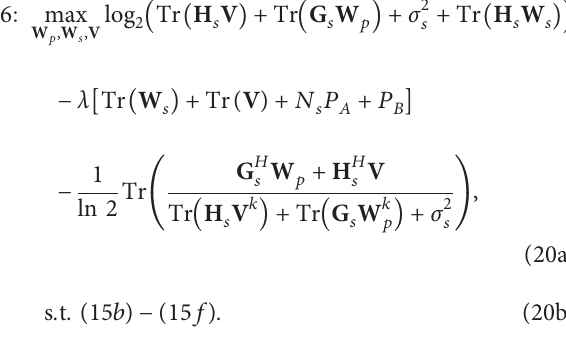
Algorithm 1 presented in the pseudo code diagram sum- marizes the algorithm procedures based on the DC